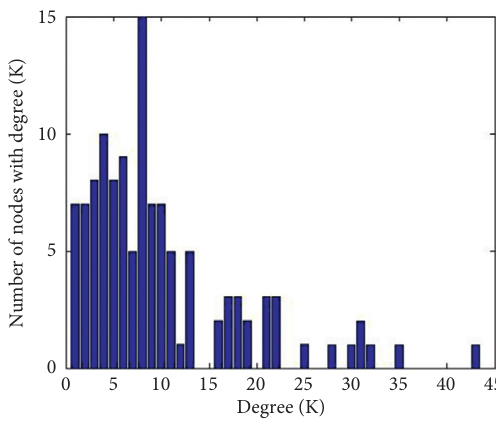
Figure 3: The degree distribution.